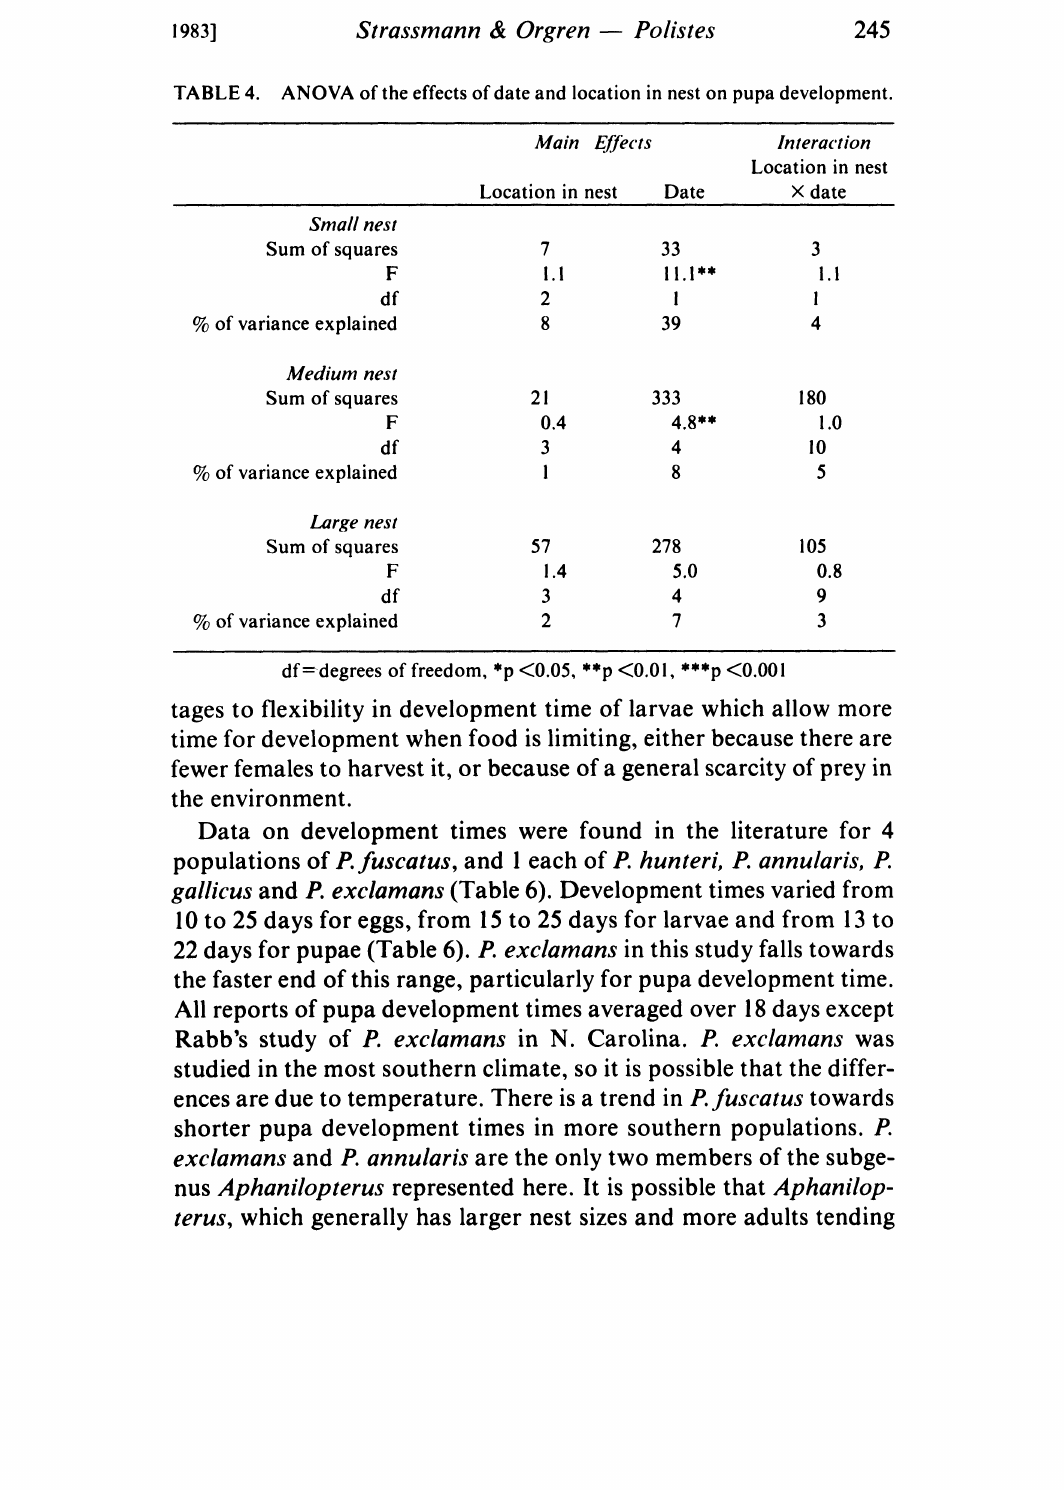
TABLE 4. ANOVA of the effects ofdate and location in nest on pupa